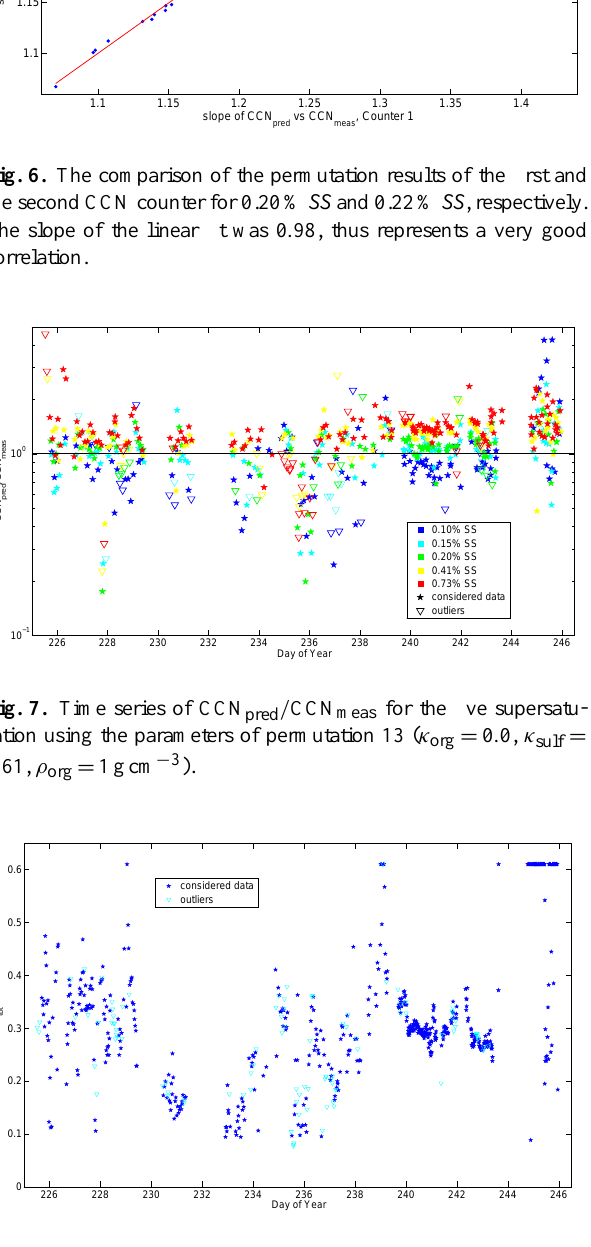
Fig. 8. The time series of the total κ value using the parameters of permutation 13 ( κ org = 0 . 0, κ sulf = 0 . 61, ρ org = 1gcm − 3